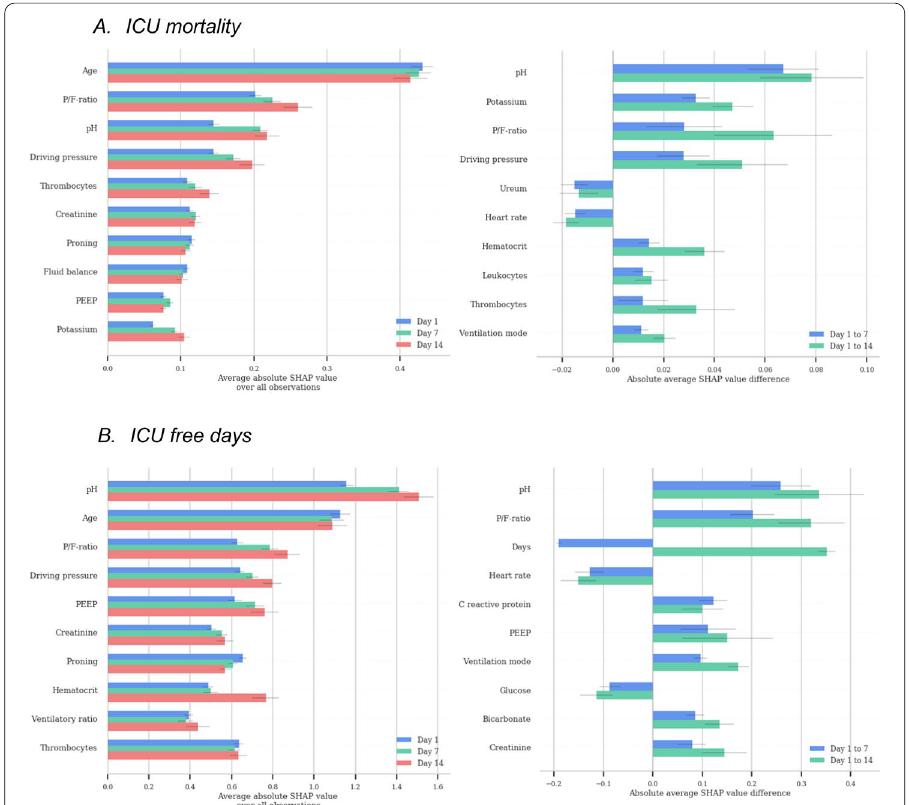
Fig. 1 Importance of the top 10 predictors for the prediction of ICU mortality and ICU free days, as well as the difference for predictors over time. A ICU mortality. B ICU‑free